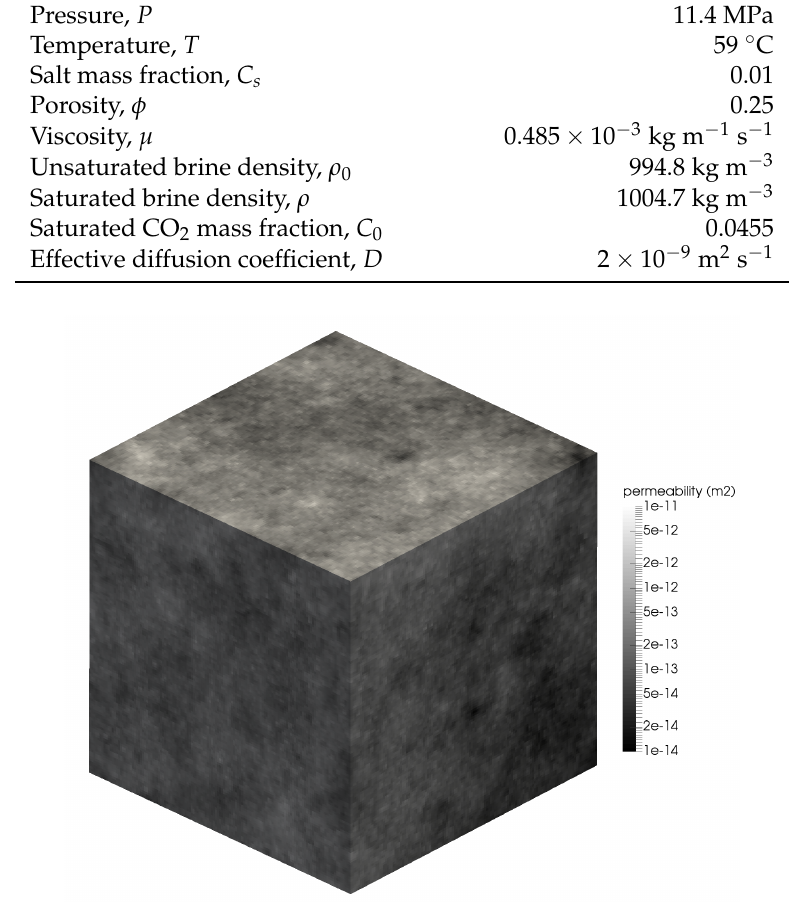
Figure 4. Fractional Lévy motion model of permeability heterogeneity. Width parameter α = 1.25, Hurst parameter H =